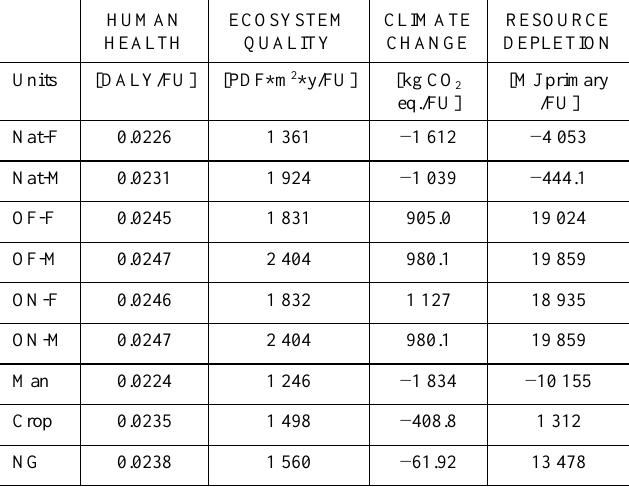
E NVIRONMENTAL CRITERIA VALUES GAINED FROM LCA IN S IMA P RO HUMAN ECOSYSTEM CLIMATE RESOURCE HEALTH QUALITY CHANGE DEPLETION